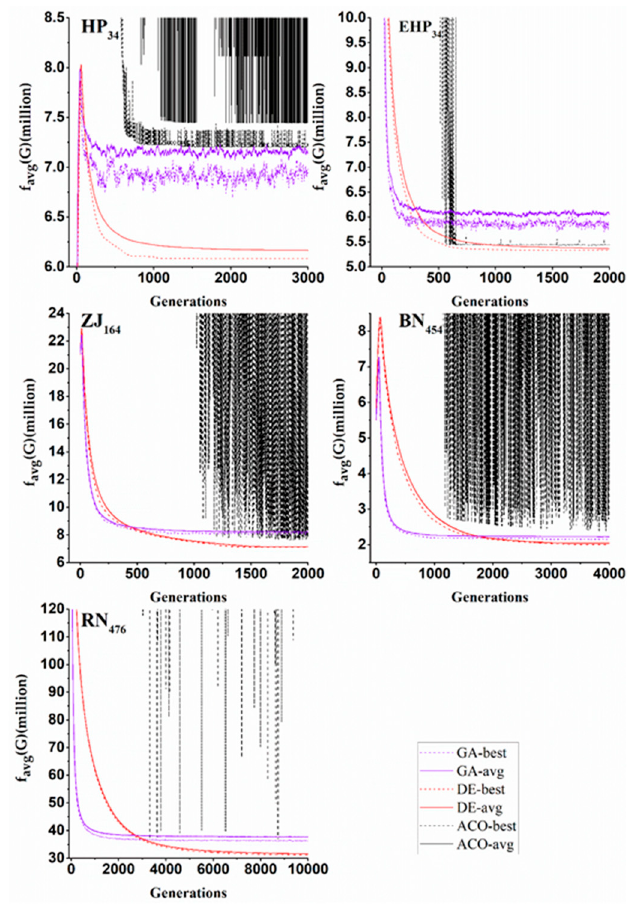
Figure 3. Solution quality metric f avg ( G ) of the three di ff erent types of EAs applied to the five case studies.